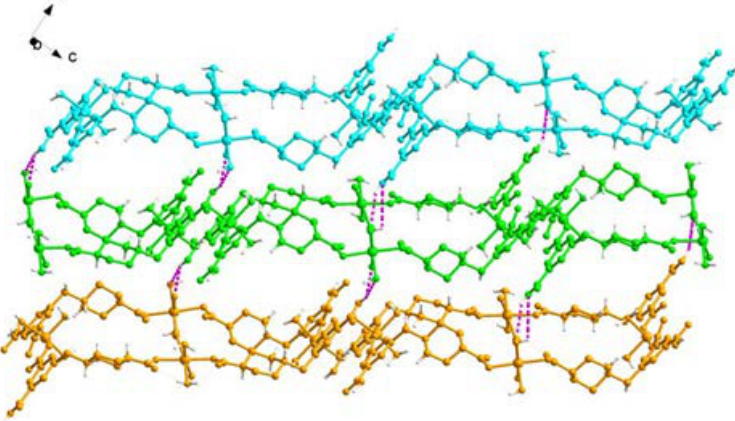
Figure 3. The 2D layer structure linked by rich hydrogen bond interaction.